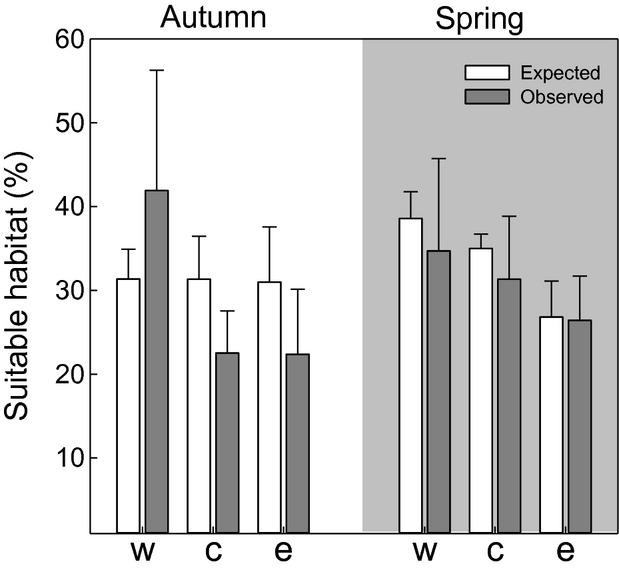
Habitat composition along expected shortest routes and observed routes during autumn (left) and spring migration (right) of common nightingales. Suitable habitats encompass forests; semi-open and open habitats (see methods for habitat categories, Fig. 1 for continental distribution). Bars give mean percentage (±SD) for birds from western (w), central (c) and eastern population (e).